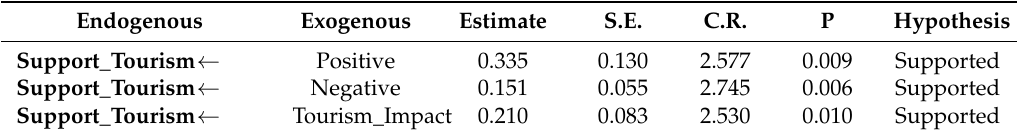
Table 3. Regression